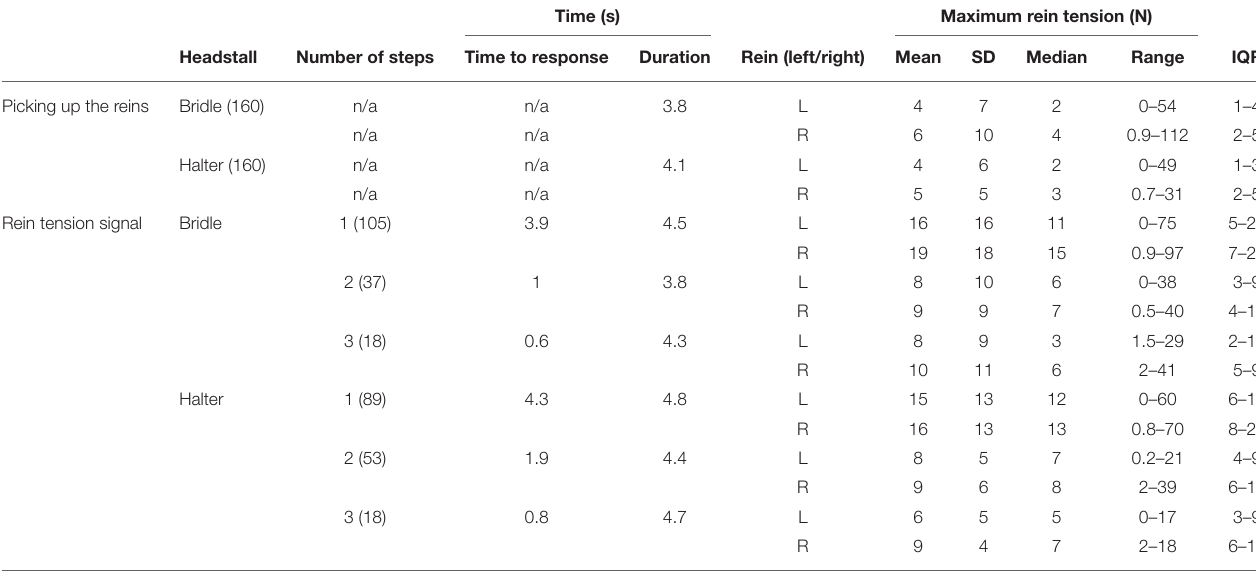
TABLE 2 | Descriptive statistics on time variables and maximum rein tension of the phases picking up the reins and rein tension signal.